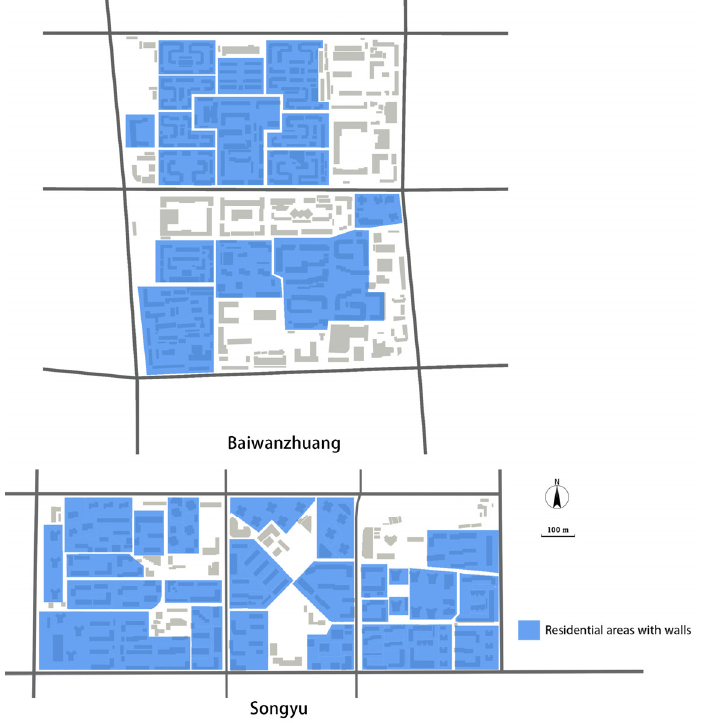
Figure 5. Residential area zones with walls in the neighborhoods.